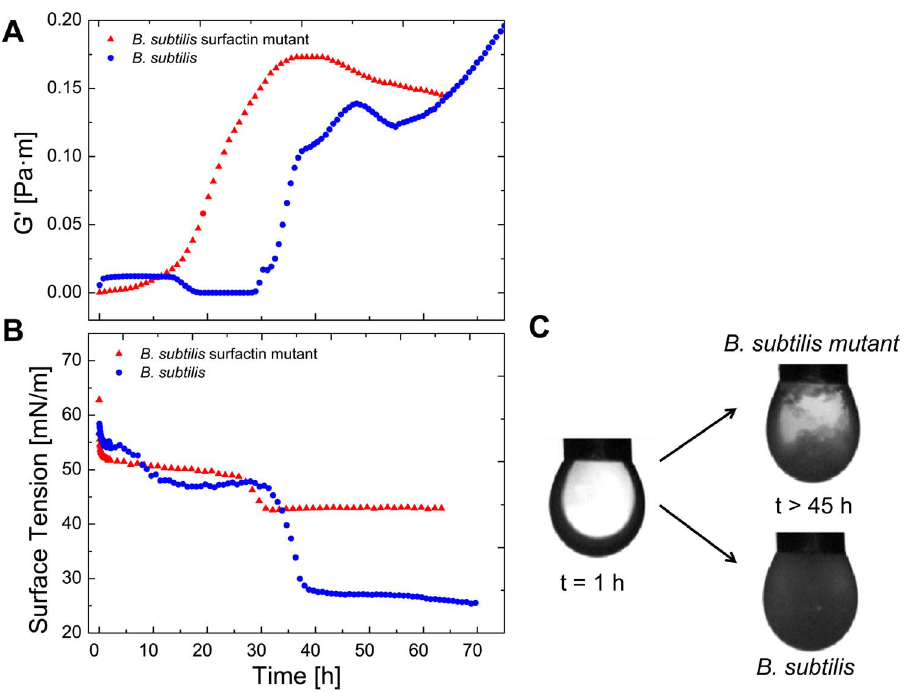
Figure 6. Effect of surfactin production on biofilm formation of B.subtilis . A: The elasticity (G0) of B. subtilis and B. subtilis surfactin mutant is plotted against the time. B: The surface tension versus time is plotted of B. subtilis and B. subtilis surfactin mutant. C: Images of the pendant drop experiment of B. subtilis and B. subtilis before and after biofilm growth (C) (t . 45 h).